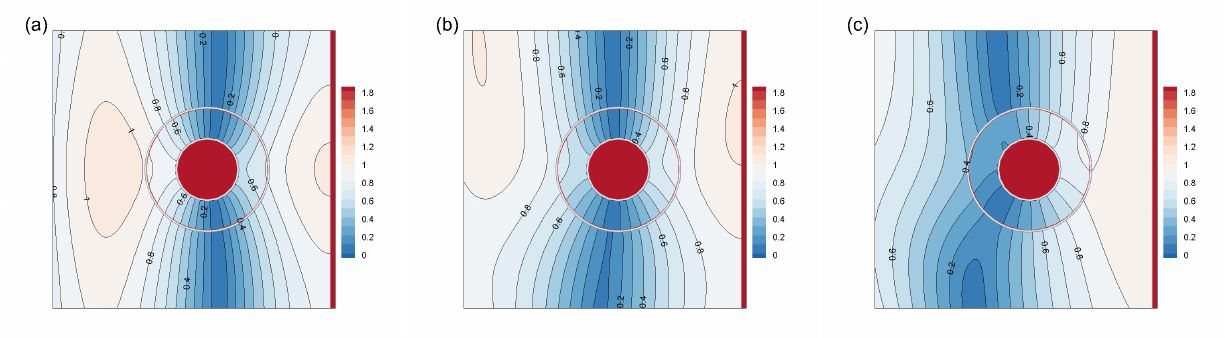
Figure 6. Wave elevation in the vicinity of a concentric system near a vertical wall with ka = 0.8, G 1 = G 2 = 1, c / a = 0.5, e / a = 1, h / a = 1.5: ( a ) β = 0 ( b ) β = 30 ◦ ( c ) β = 45 ◦